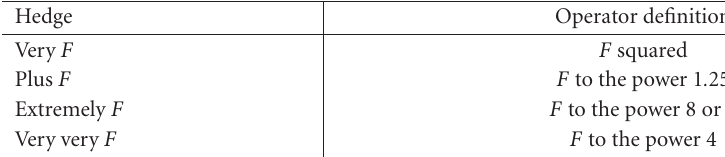
Table 2.1. Concentrators.